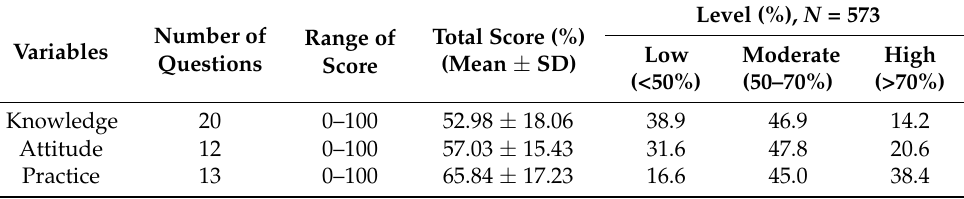
Table 2. The number of questions, range, score, and level of knowledge, attitude, and practice.